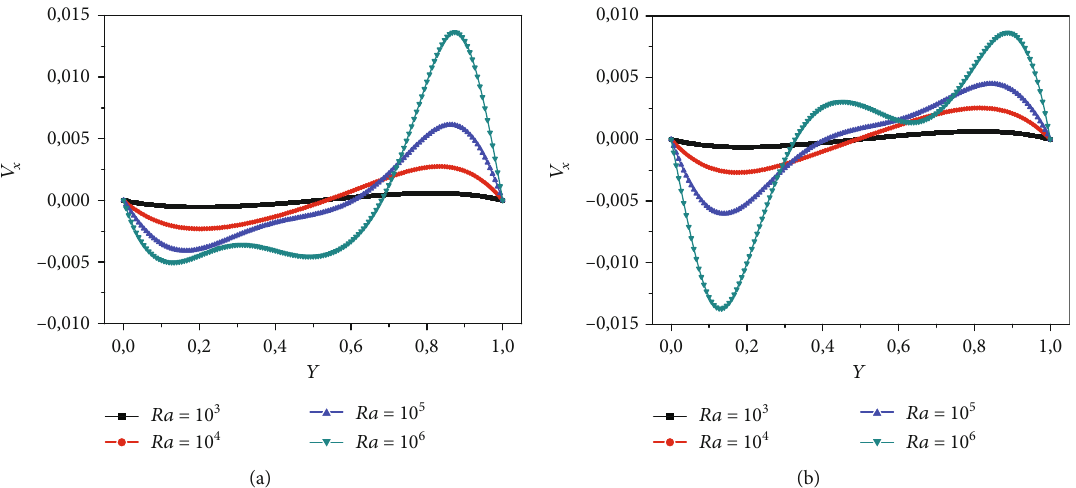
Figure 8: x -component velocity pro fi les as a function of y -coordinate for di ff erent Rayleigh numbers Ra , for a hot (a) and cold (b) chip length of h = H /3